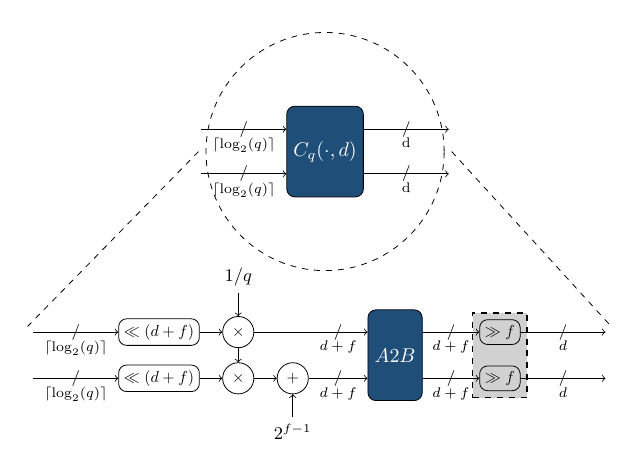
Figure 4: MaskedCompress